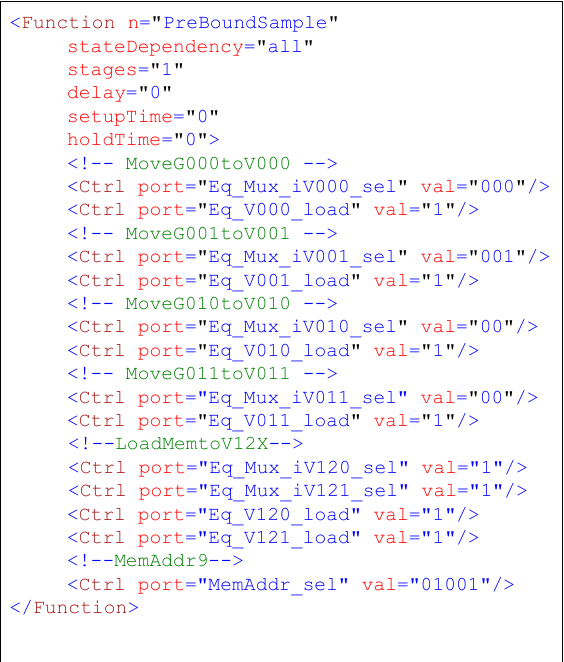
Figure 9. Pre-bound function sample that merges multiple operations.